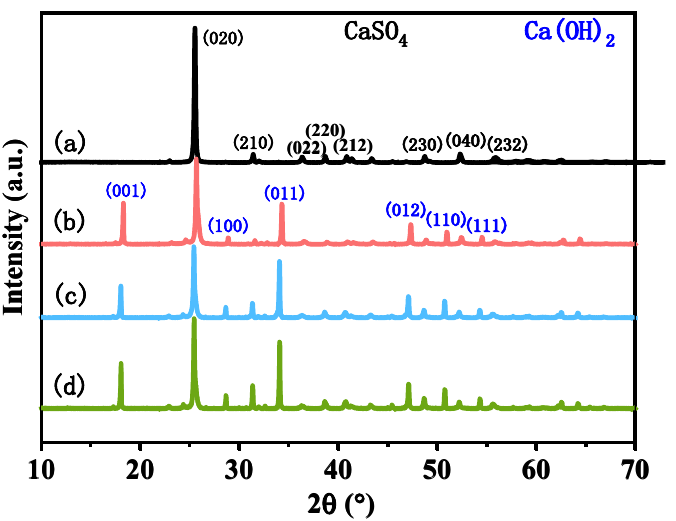
Figure 2. XRD patterns of ( a ) untreated CSWs, ( b ) CSW-OH, ( c ) CSW-OH-KH570, and ( d ) CSW-g-